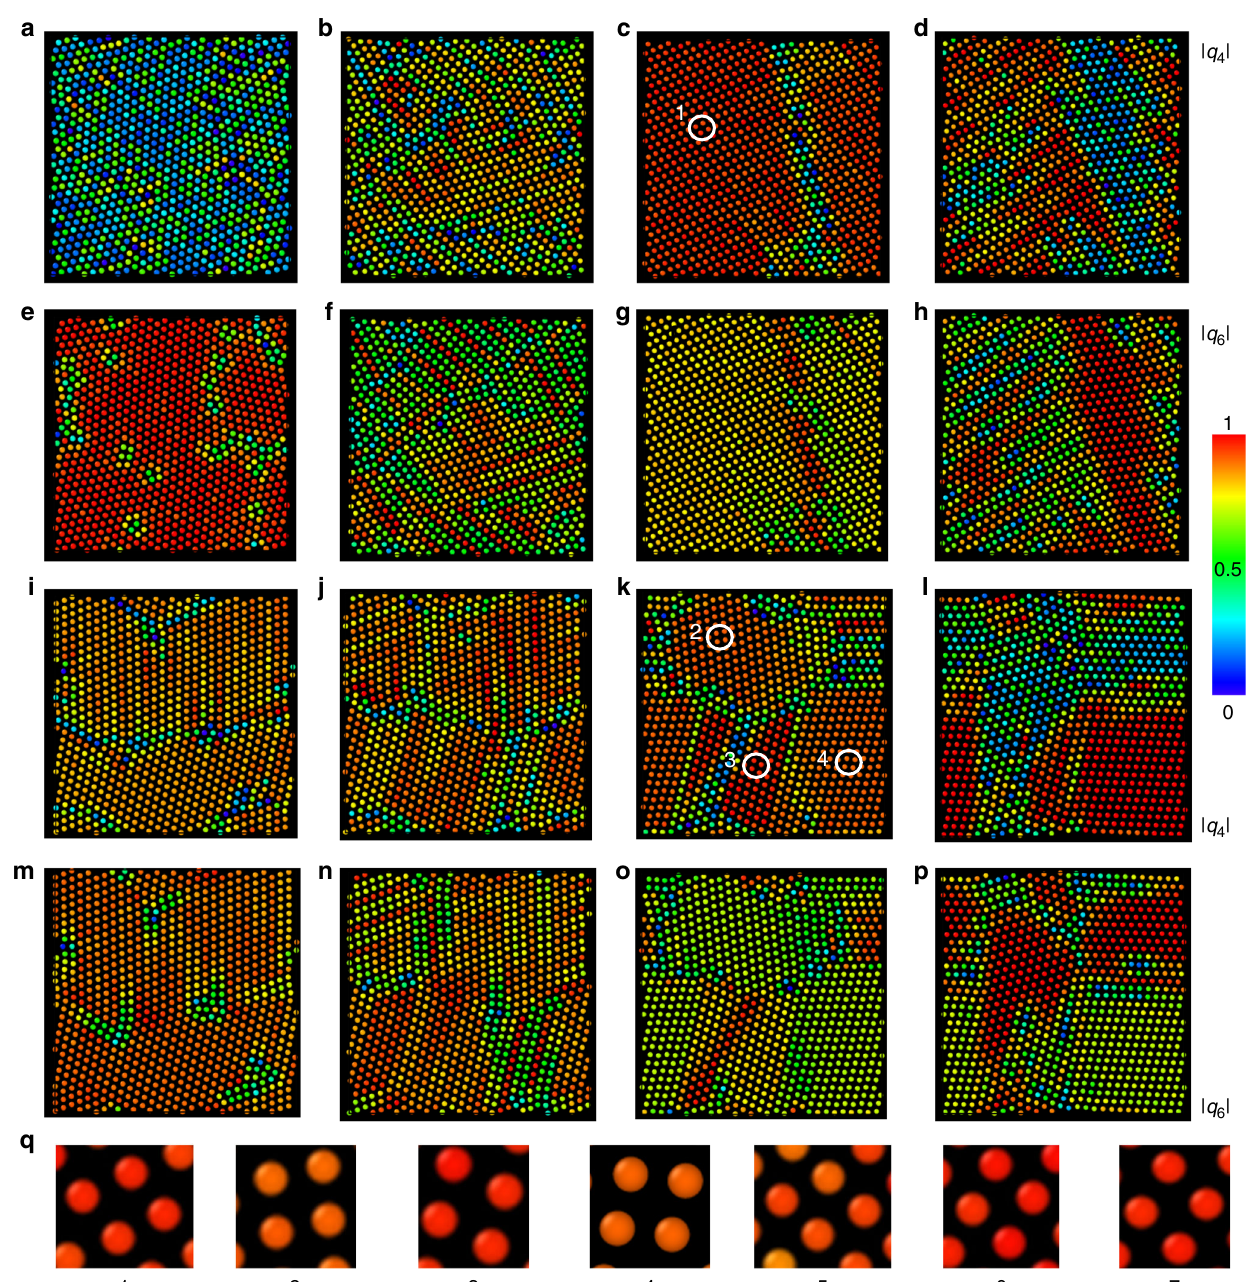
Fig. 10 Self-assembly of hexadecapole colloids with longer-stronger Yukawa repulsion. a – h Snapshots of the temporal evolution of self-assembled structures. Panels in the same column are taken at the same time during the simulation; time elapses from ( a ) to ( d ). Spheres in the top (bottom) row are colored according to the absolute value of the local quartic order parameter q 4 ( j ) (hexatic order parameter q 6 ( j )) as marked on the right with the color scale as an inset. Parameters used are Q 4 ¼ 9 ´ 10 (cid:2) 5 ; r c in ( c ), ( g ); and L x ´ L y ¼ 37 ´ 37 R 2 ( b ), ( f ); L x ´ L y ¼ 36 ´ 36 R 2 eff and colored in the same way as ( a ) – ( h ). Parameters used are Q 4 ¼ 9 ´ 10 (cid:2) 5 ; r c in ( j ), ( n ); L x ´ L y ¼ 36 ´ 36 R 2 ( m ); L x ´ L y ¼ 35 ´ 35 R 2 eff